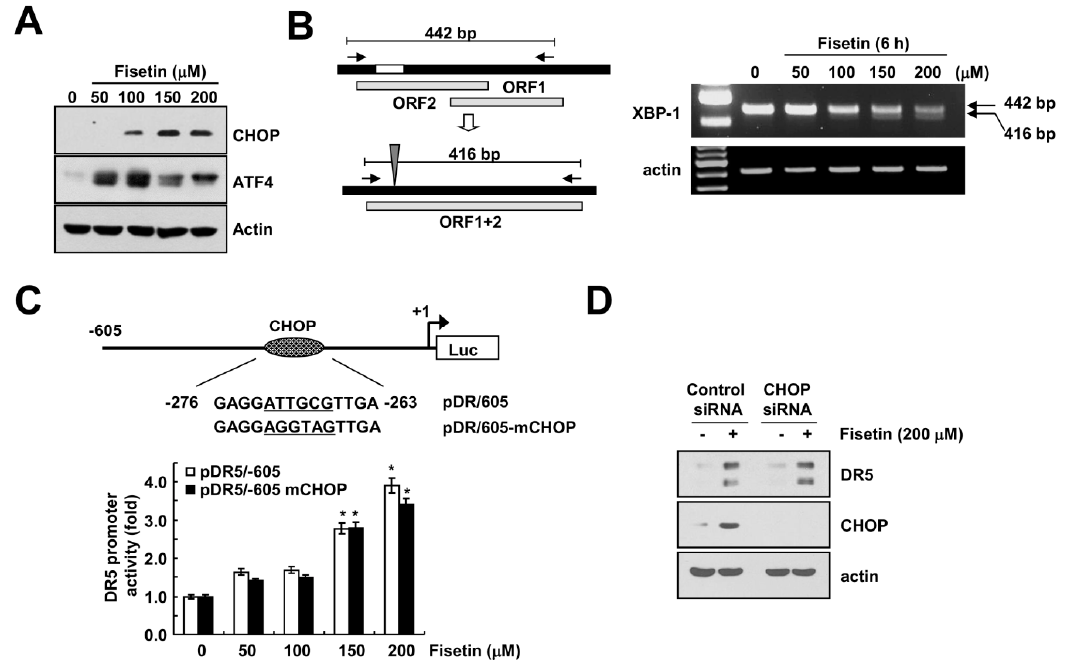
Figure 4. Up-regulation of CHOP expression has no effect on DR5 expression in fisetin-treated cells. ( A , B ) Caki cells were treated with the indicated concentrations of fisetin for 6 h; ( A ) The protein expression levels of CHOP, ATF4 and actin were determined by western blotting; ( B ) The mRNA expression levels of XBP-1 and actin were determined by RT-PCR. The level of actin was used as a loading control; ( C ) Caki cells were transiently transfected with pDR5/-605 or CHOP-mutated pDR5/-605 and then treated with the indicated concentrations of fisetin for 24 h. After treatment, cells were lysed and assayed for luciferase activity; ( D ) Caki cells were transfected with control or CHOP siRNA. Twenty-four hours after transfection, cells were treated with 200 μ M fisetin for 24 h. The protein expression levels of DR5, CHOP and actin were determined by western blotting. The level of actin was used as a loading control; the values in ( C ) represent the mean ± SD from three independent samples. * p < 0.01 compared to